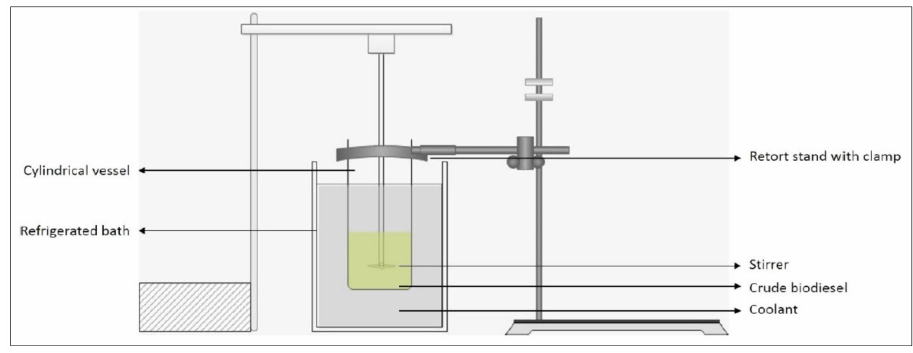
Figure 7. Solvent-aided crystallization method